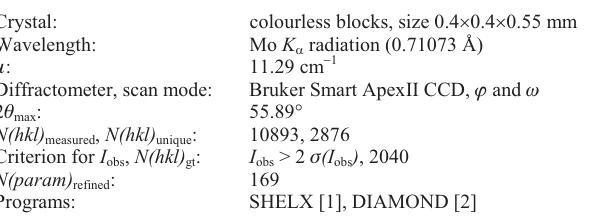
Table 2. Atomic coordinates and displacement parameters (in Å 2 )